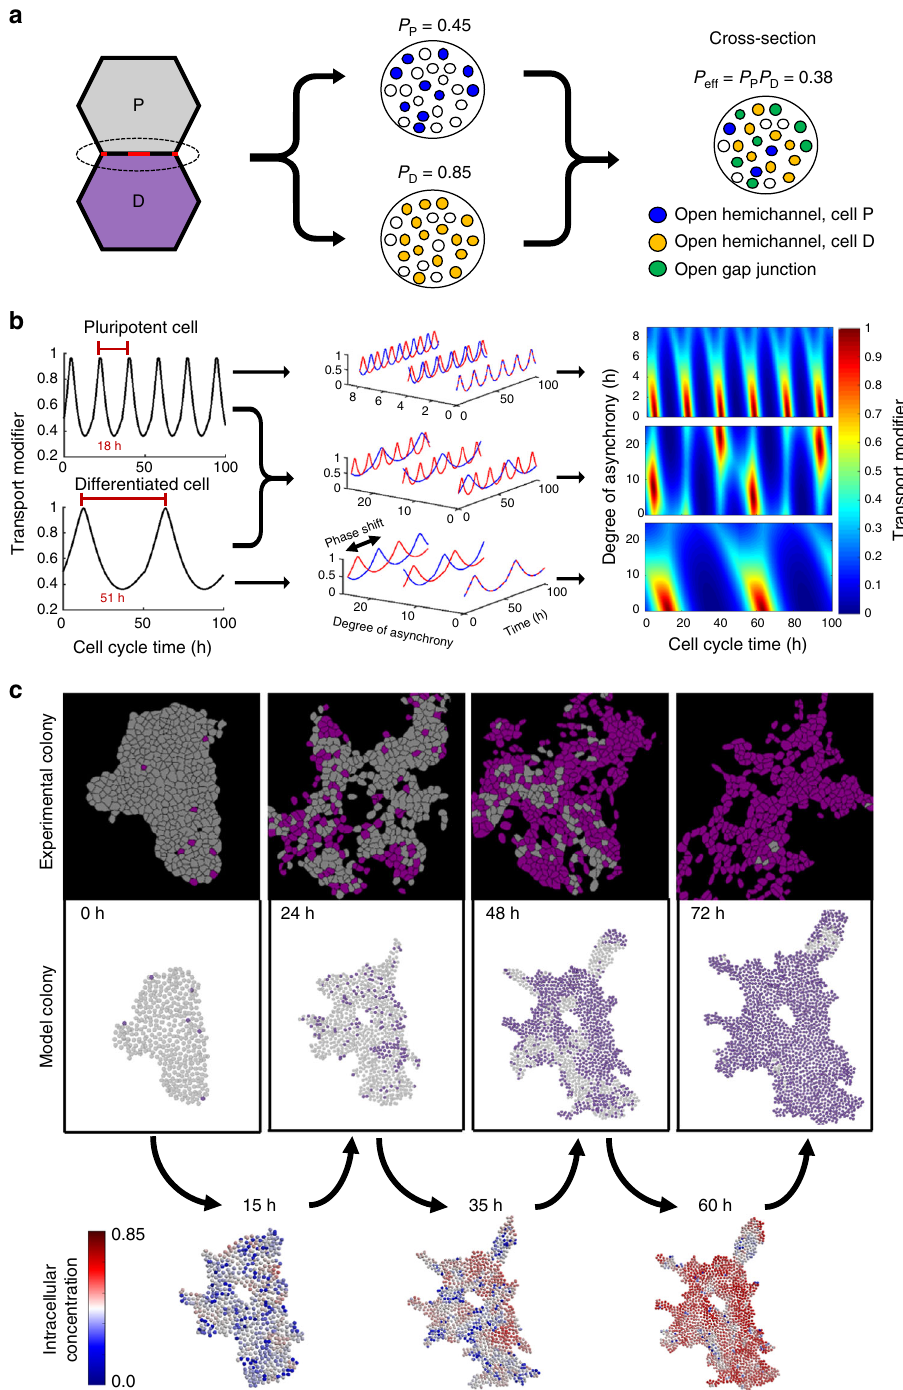
Fig. 4 Computational analysis of cell-cycle modulation on intercellular communication. a Each cell type (P, pluripotent; d, differentiated) has a base permeability, representing the average percent of gap junction hemichannels open at a cell-cell interface, with the total percent of open channels being the product of the two base permeabilities. b A function for cell-cycle modulation over time was de fi ned based on the transport trends noted in Fig. 3, with a convolution of all possible transport pro fi les that two cells could experience over time for P-P, P-D, and D-D. c The intercellular transport model was implemented within an agent-based model and compared to digitized experimental colonies over time. Supplementary Movie 1 is a representative video of the progression of intracellular gradient formation and